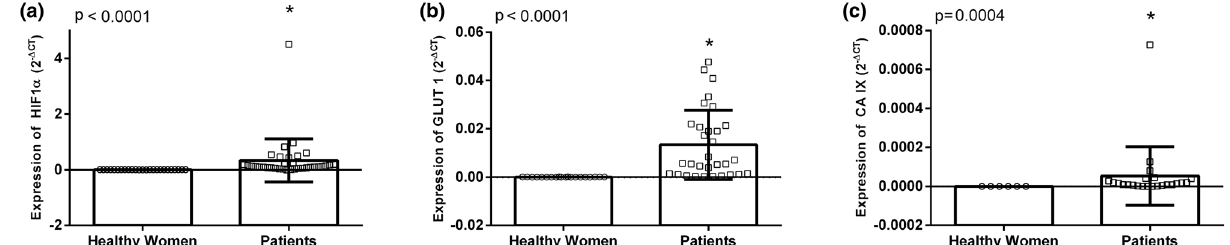
Figure 1. Graphic representation of the difference in expression of HIF-1α ( a ), GLUT1 ( b ) and CAIX ( c ) genes between peripheral blood samples from healthy donors and breast cancer patients (Mann–Whitney test, CI95% confidence interval of 95%). Gene expression was accessed by 2 −ΔCt formulae before the beginning of the treatment.